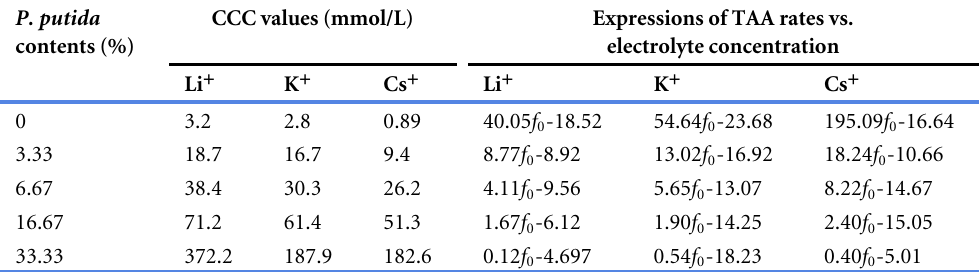
Table 1 Expressions of the TAA rates for the aggregation of mixed particles in the various alkali ion solutions when the electrolyte concentration is less than the